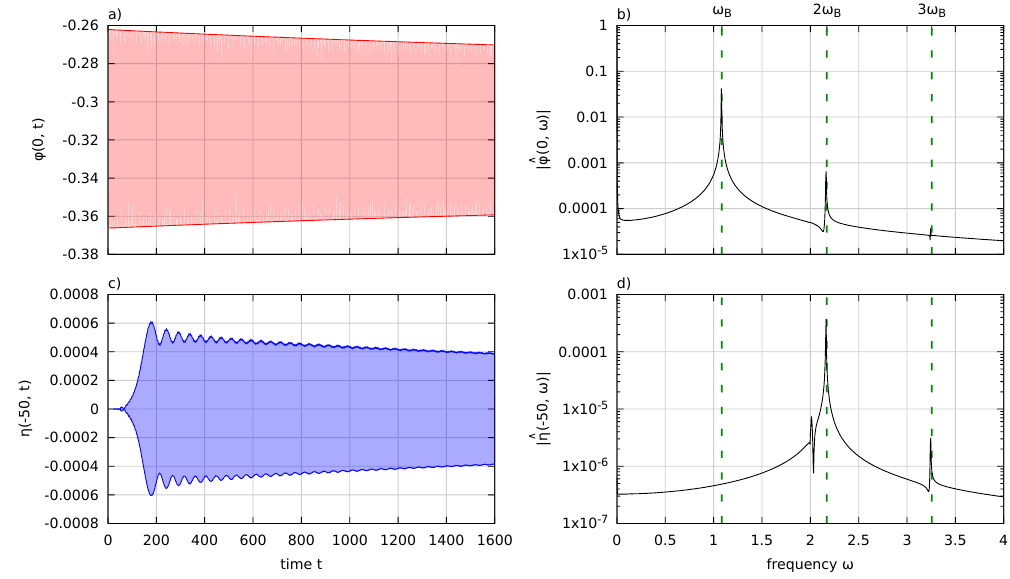
Figure 11 . Evolution of the boundary mode for H = 0 : 90 < H 2 , with initial conditions (cid:30) ( x; 0) = (cid:30) 1 ( x ) + 0 : 05 (cid:17) B ( x ), (cid:30) t ( x; 0) = 0 : a) the amplitude of the boundary mode as a function of time; b) its power spectrum, found by taking the Fourier transform of (cid:30) (0 ; t ) for 0 < t < 1600; c) the values of (cid:17) ( x; t ) := (cid:30) ( x; t ) (cid:0) (cid:30) 1 ( x ) at x = (cid:0) 50; d) its power spectrum, taken from (cid:17) ( (cid:0) 50 ; t ) for 200 < t < 1600. In plots a) and c), solid non-transparent lines join local extrema of the measured (cid:12)eld at the given position.